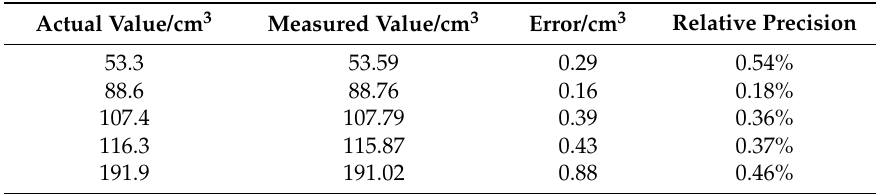
Table 4. Accuracy verification experiment with collection shovels of different sizes.